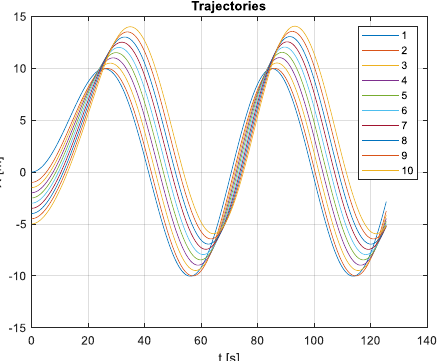
Figure 21. Position of the AGV and the trailers in the x-coordinate for the circumference trajectory.